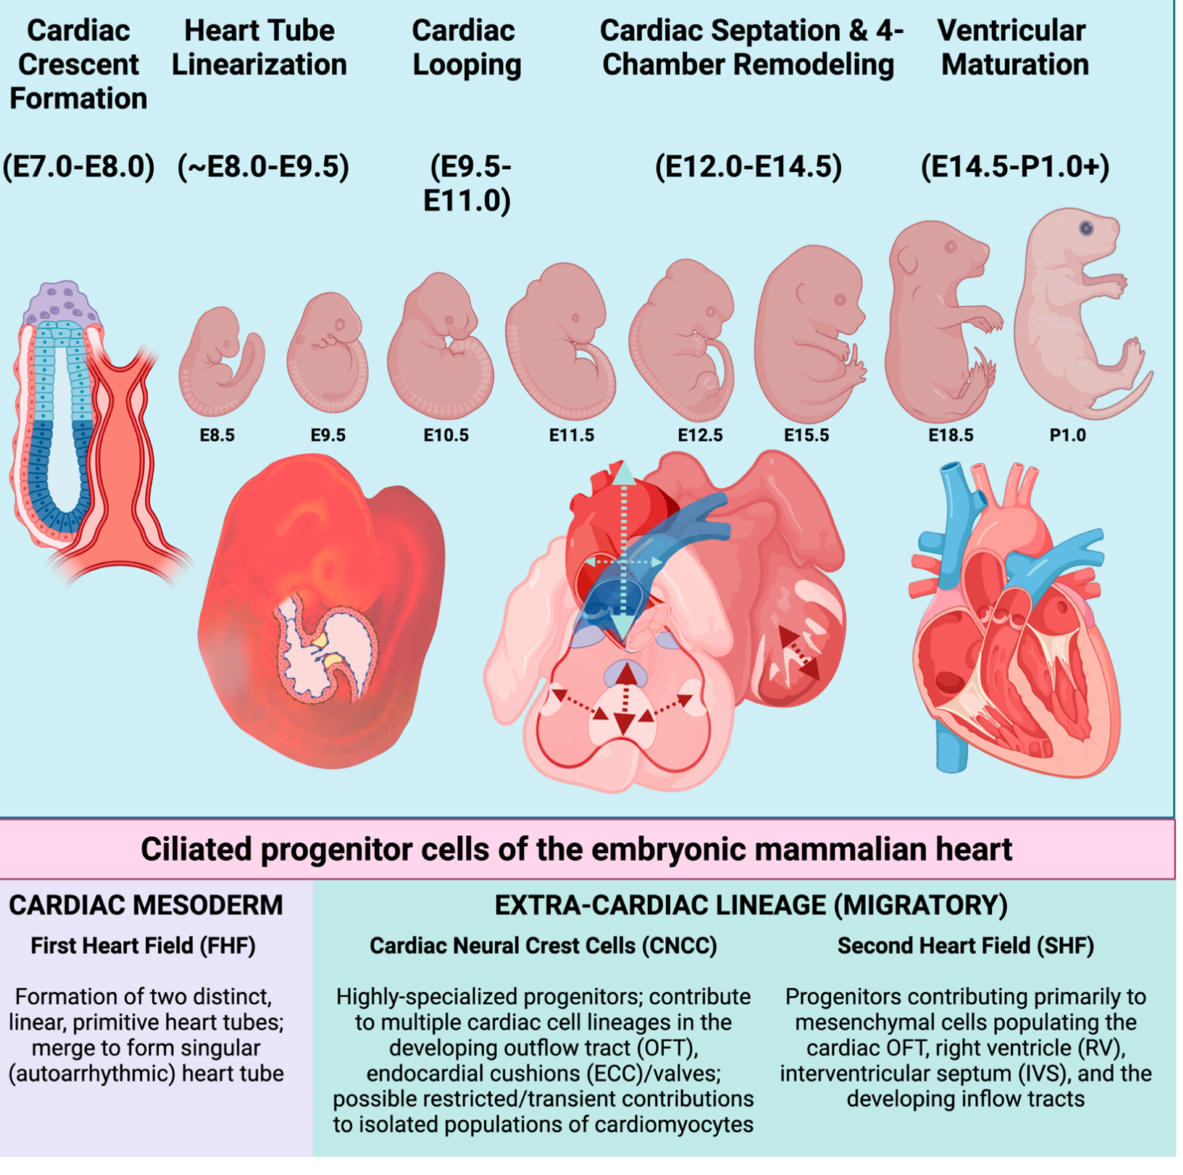
Figure 1. Schematic overview of embryonic heart development in the mouse. Embryonic days of gestation (“E”) are indicated beneath each stage and indicate the number of days post-coitus. Mammalian cardiogenesis involves an intricate number of developmental stages, many of which are orchestrated by, and are dependent upon, the presence of intact primary cilia (From left to right). Broadly speaking, embryonic heart development in the mouse can be divided into stages involving the initial formation of cardiac crescent/primitive heart tube, linearization of the heart tube, cardiac looping (to orient the future chambers in space), cardiac septation, and ventricular remodeling and maturation. Each of these stages requires cellular contributions from one or more of the progenitor cell populations indicated beneath the illustration. These progenitors elaborate primary cilia and originate either intrinsically from within the cardiac mesoderm, or they must migrate to the developing heart from an extra-cardiac location. Upon arrival near or within the developing heart, CNCC and SHF progenitors will later differentiate into many of the terminally differentiated cell types. First heart field (FHF); cardiac neural crest (CNCC); outflow tract (OFT); endocardial cushions (ECC); second heart field (SHF), right ventricle (RV); and interventricular septum (IVS). Figure created with Biorender.com (accessed on 29 May